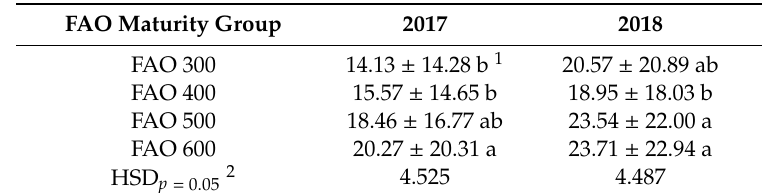
Table 3. The average percent of plants ( ± SD) infested by European corn borer (ECB) larvae established on corn hybrids belonging to di ff erent FAO maturity groups in 2017 and 2018 and the results of statistical analysis.